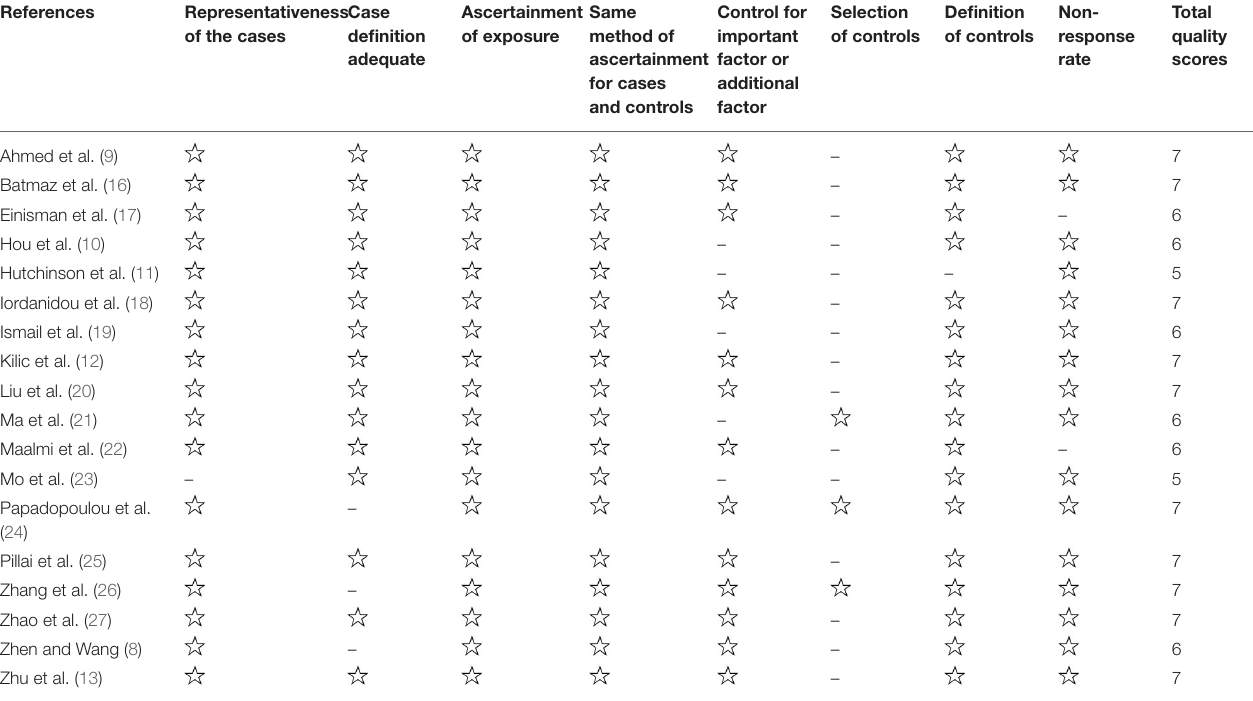
TABLE 3 | Quality assessment of the included